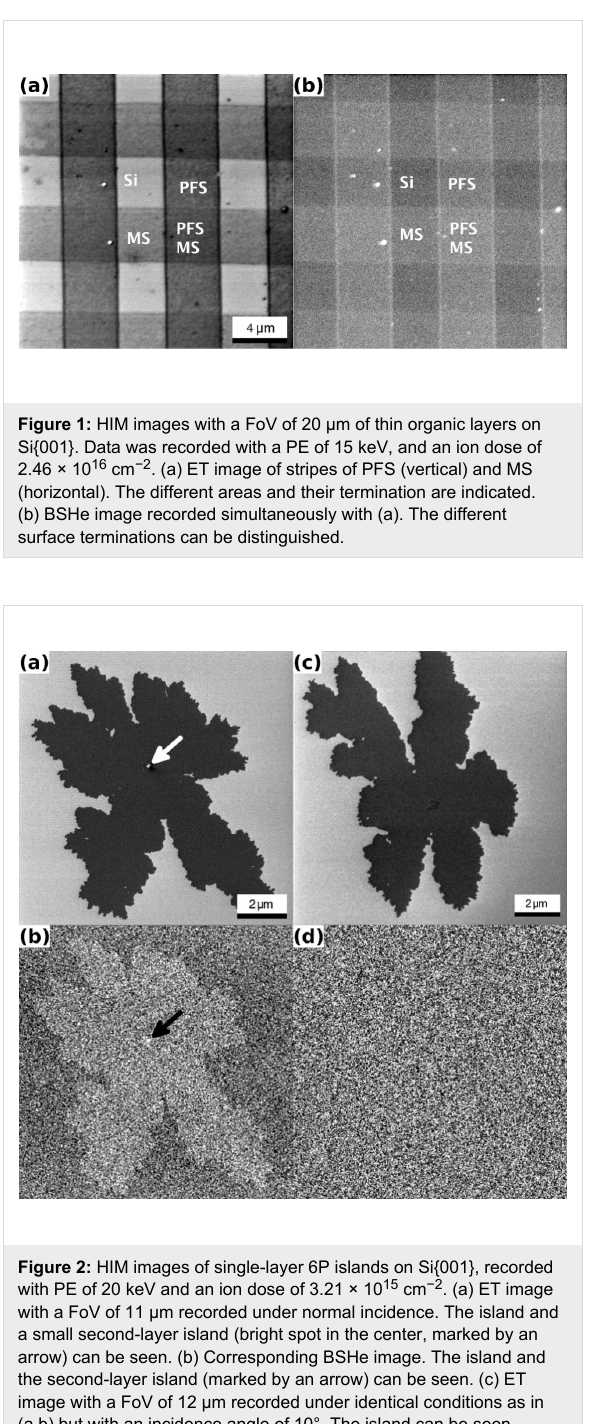
Figure 2: HIM images of single-layer 6P islands on Si{001}, recorded with PE of 20 keV and an ion dose of 3.21 × 10 15 cm − 2 . (a) ET image with a FoV of 11 μ m recorded under normal incidence. The island and a small second-layer island (bright spot in the center, marked by an arrow) can be seen. (b) Corresponding BSHe image. The island and the second-layer island (marked by an arrow) can be seen. (c) ET image with a FoV of 12 μ m recorded under identical conditions as in (a,b) but with an incidence angle of 10°. The island can be seen clearly. (d) In the corresponding BSHe image the island is